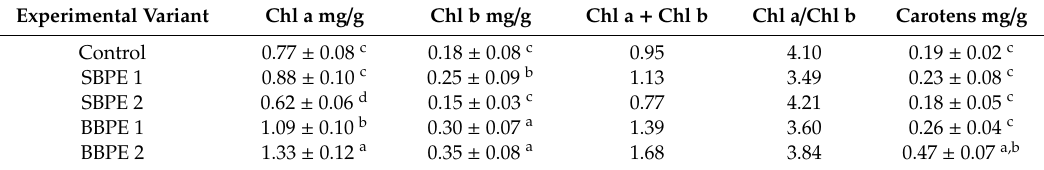
Table 1. Content of photo-assimilatory pigments synthesized (mg / g) in lemon balm leaves.